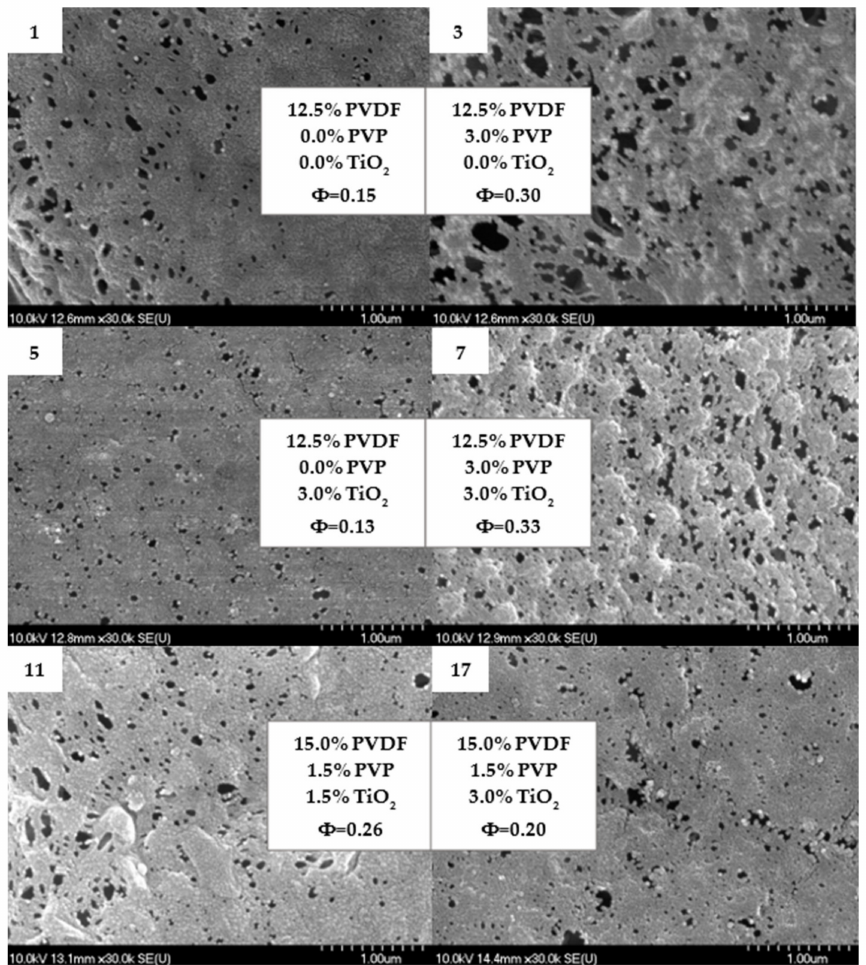
Figure 3. Scanning electron microscopy images of the top surface of 6 different membranes containing PVDF, PVP and TiO 2 . Φ is the calculated average pore size in µ